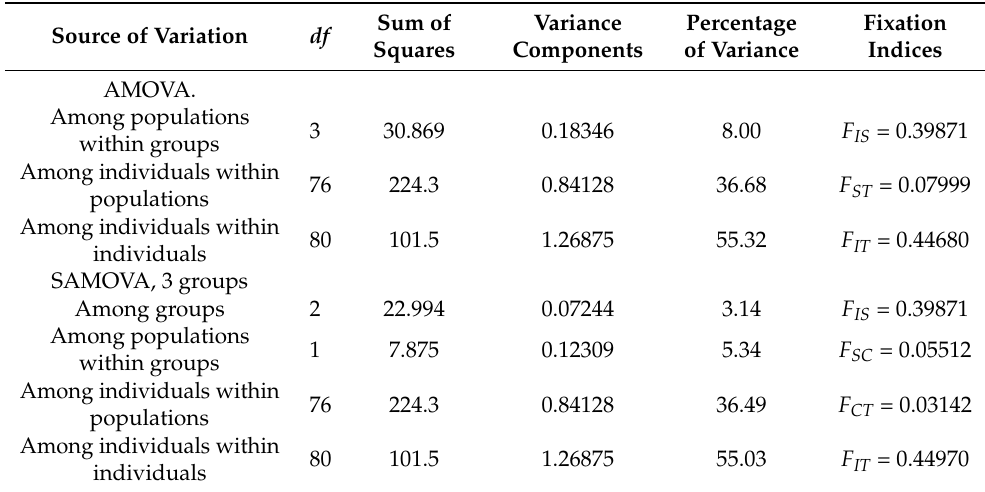
Table 3. Summary of AMOVA and SAMOVA statistics for alternative groupings of populations. Source of Variation df